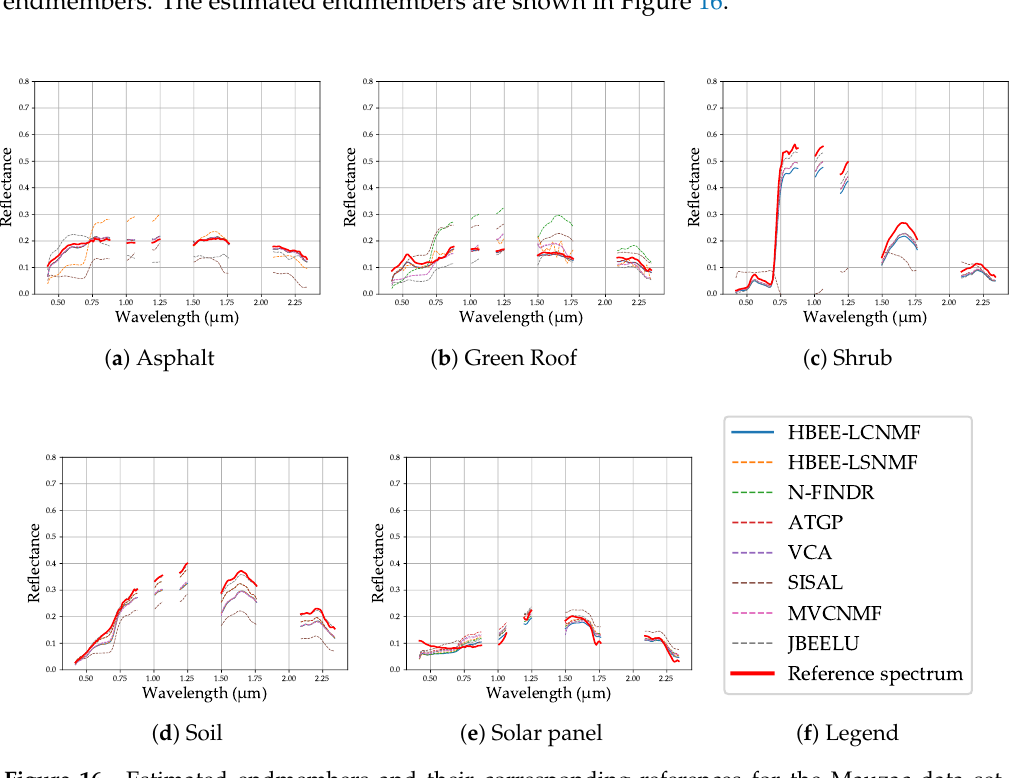
Figure 16. Estimated endmembers and their corresponding references for the Mauzac data set. The SAM criterion is used to match the estimated endmembers with the reference